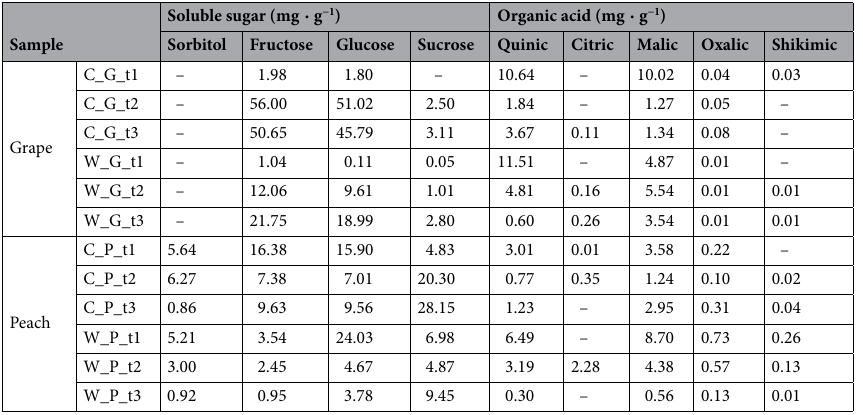
Table 3. Sugar and acid content of cultivated and wild grapes and peach fruits in three periods.